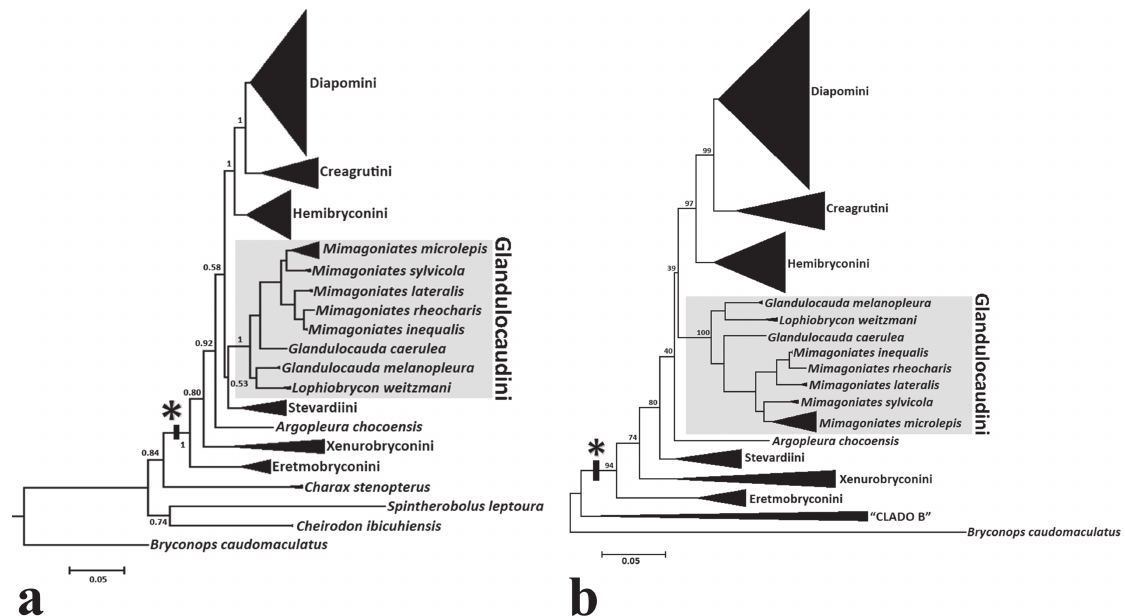
Fig. 1. Abbreviated phylogenetic trees of Stevardiinae (asterisk) obtained in this study based on concatenated dataset (16S+COI+RAG2, 1,829 bp), indicating the placement of the tribe Glandulocaudini (highlighted): a. Bayesian tree, numbers at branches are posterior probabilities and b. Maximum likelihood tree, numbers at branches are bootstrap values, “Clade B” = ( Charax stenopterus ( Cheirodon ibicuhiensis , Spintherobolus leptoura )).